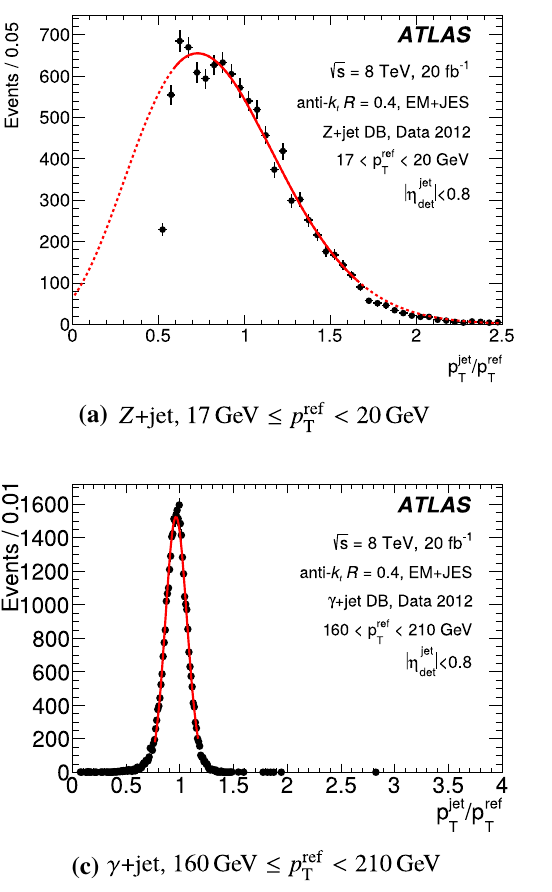
/ p ref < 20GeV, Fig. 21 Distributions of p j1 for a 17GeV ≤ p ref Poisson distributions of Eq. (20), from which the means are taken as T T T < 80GeV, c 160GeV ≤ p ref < 210GeV, and the DB response measurements R DB . The solid lines indicate the fit- b 60GeV ≤ p ref T T < 600GeV using anti- k = 0 . 4 cali- ting ranges. The lack of data at low p j1 d 500GeV ≤ p ref t jets with R T brated with the EM+JES scheme in data from the a , b Z +jet and c , > 10 GeV criterion. The markers are the data counts with error bars p j1 T d γ +jet analyses. The dashed lines in a , b show the fitted Modified corresponding to the statistical